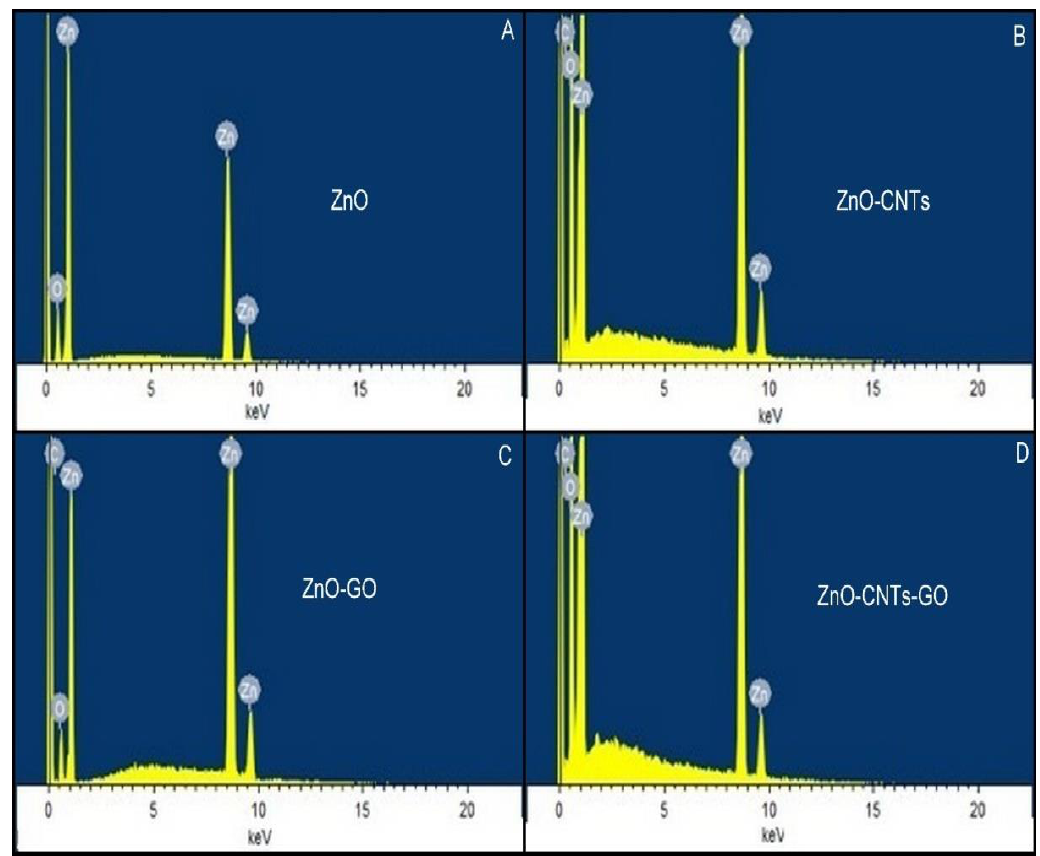
Figure 16. EDX spectra of ZnO/CNTs/GO non-material grown via the the CBD method (( A )—ZnO, ( B )—CNTs, ( C )—GO, ( D )—CNTs-Go).